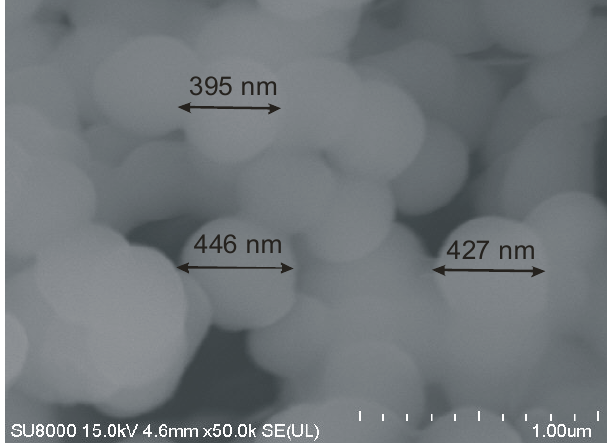
Figure 7. SEM image of Ti-MCM-41.